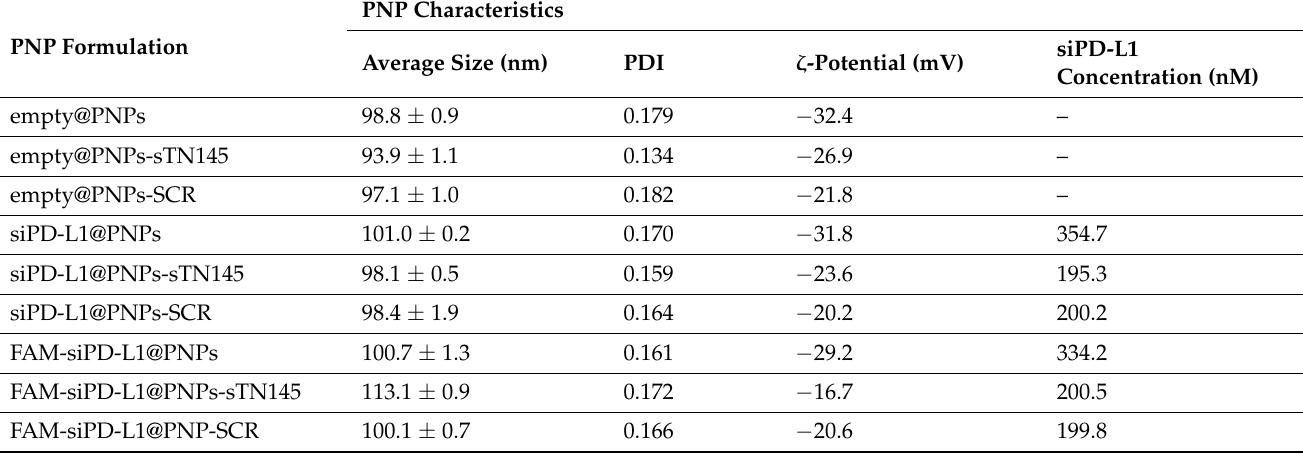
Table 1. Properties of polymeric nanoparticles.